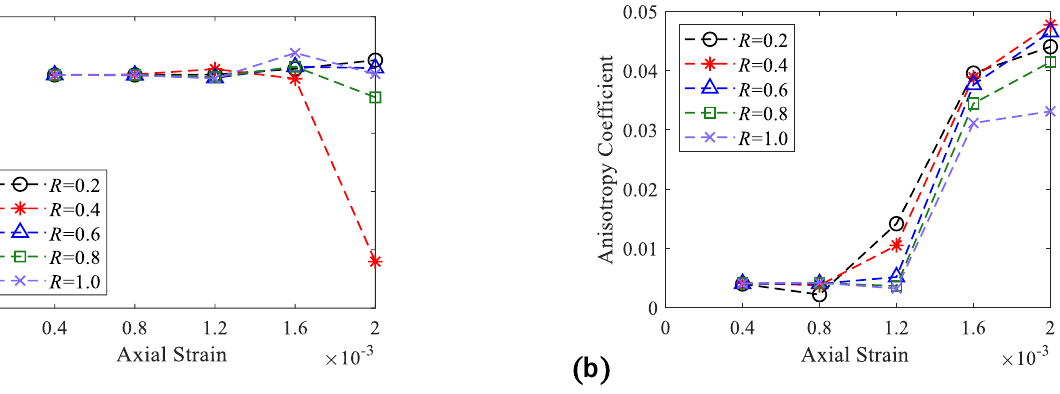
Figure 11. Contact force-chains orientation properties. ( a ) Force—chains angle axial—strain curve; ( b ) anisotropy coefficient axial—strain curve.